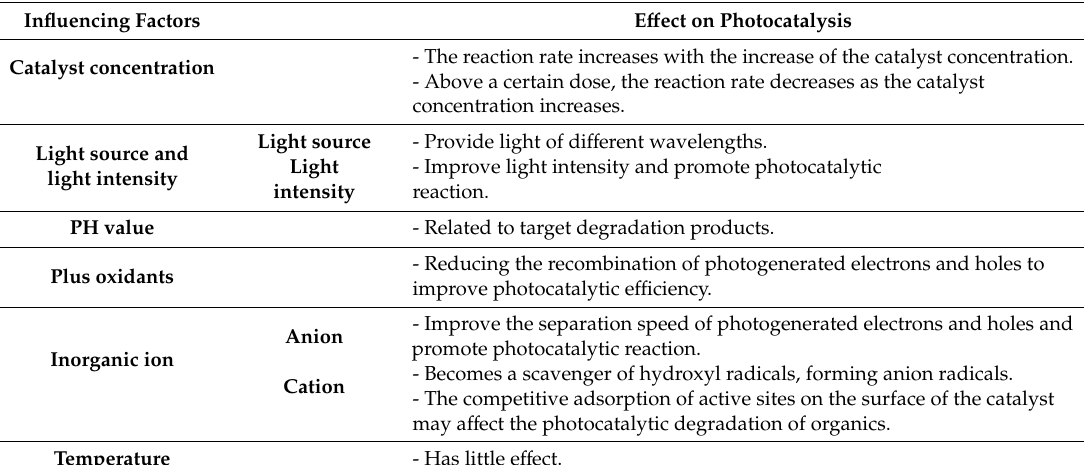
Table 1. E ff ects of influencing factors on photocatalytic